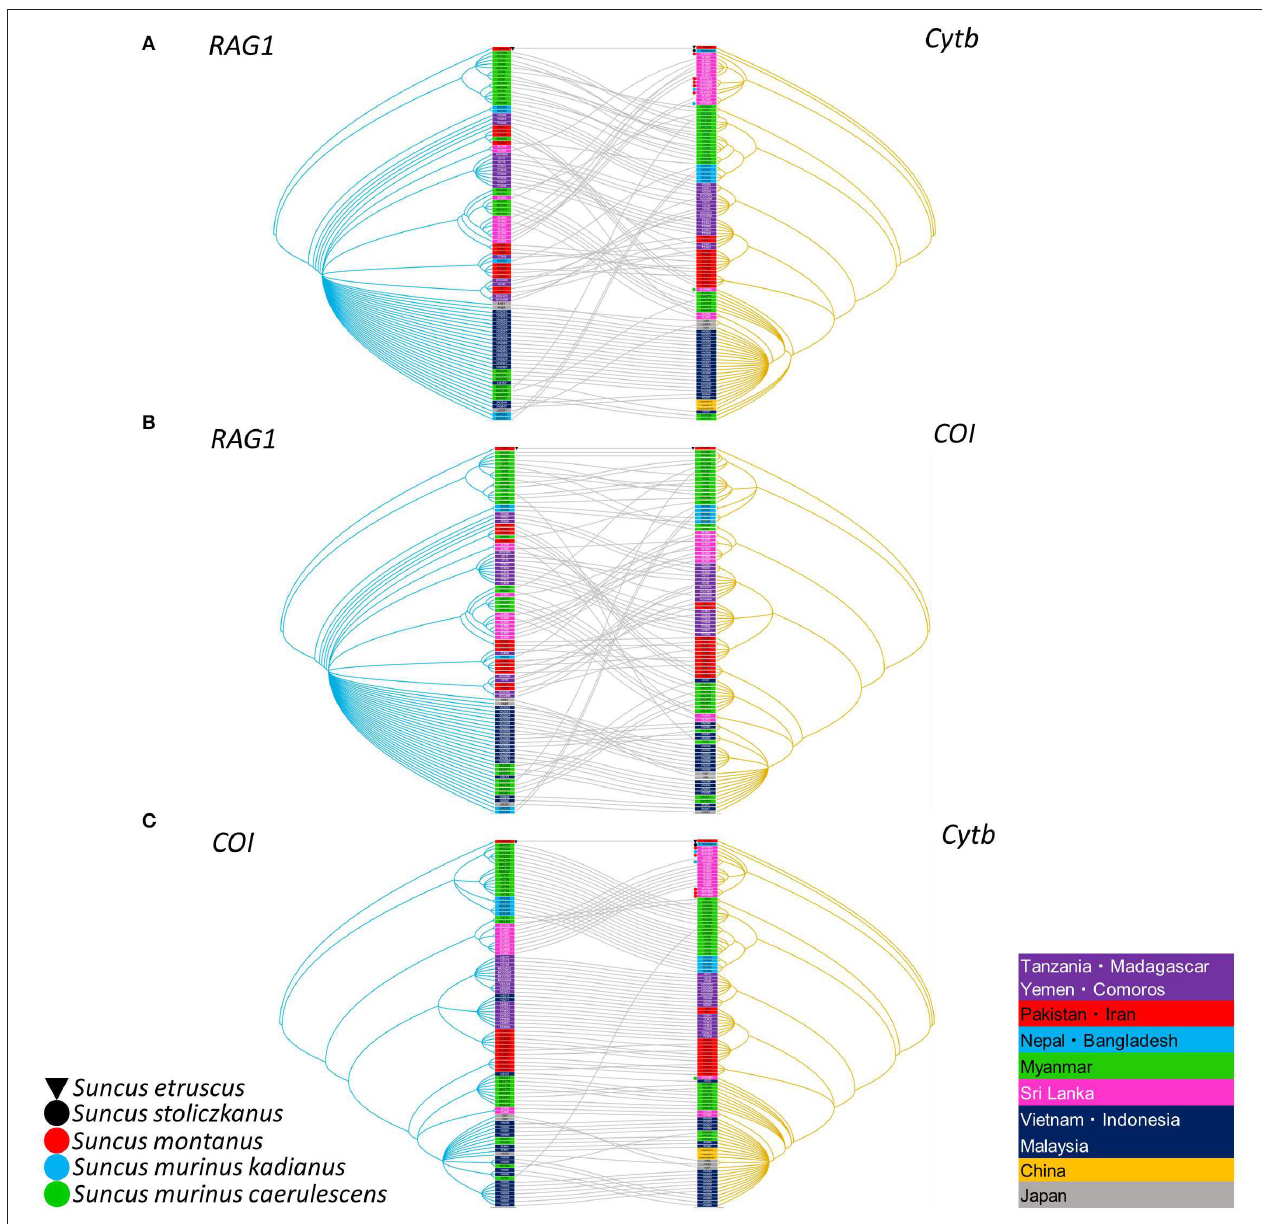
FIGURE 5 | Comparisons of nuclear and mitochondria genes generated by TreeMap 3, using Bayesian method, based on the recombination activating gene 1 (RAG1) , cytochrome b (cyt b ) gene, and cytochrome oxidase I (COI) gene of the Asian house shrew and related shrews. (A) Left tree on the RAG1 sequence, while the mitochondria tree on the right was based on the COI gene or (B) cyt b gene, and (C) also comparison of cyt b and COI genes, respectively. The nuclear ( RAG-1 ) and mitochondria relationship (cyt b and COI ) were listed in Supplementary Table 1 . Letterings for taxa are shown in right table. The deposited cyt b sequences are attached dot. The tree was rooted using Suncus etruscus (order Eulipotyphla, family Soricidae, GenBank accession numbers: cyt b , LC126597; COI , MK410384; and RAG1 , MT344767). The RAG1 order in Figures 5A,B was the same. The order of COI and cyt b in Figure 5C was adjusted for